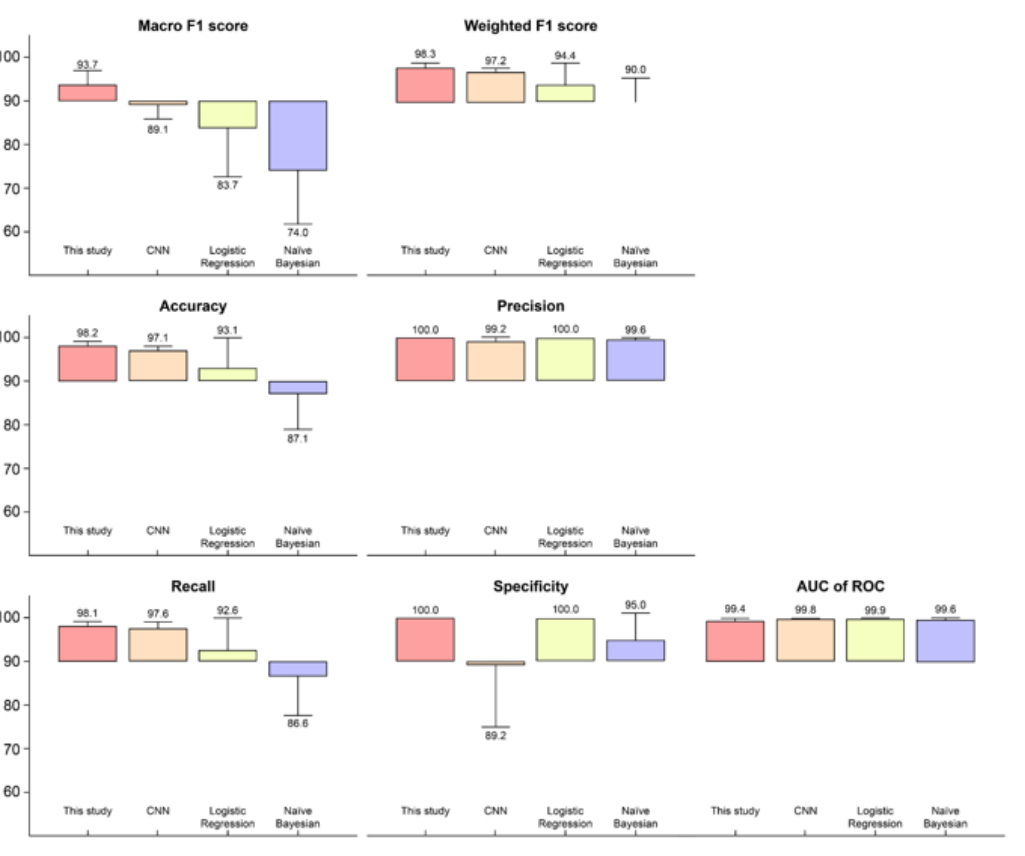
Figure 3. Performance comparisons of NSCLC prediction model with alternative classifier models. Pairwise comparisons of the implemented algorithm performances were analyzed via five-fold cross-validation. To improve discrimination, the metric cut-off was set at 90%. The standard deviation of each performance is illustrated by a vertical error bar. AUC of ROC denotes area under the receiver operating characteristic curve.